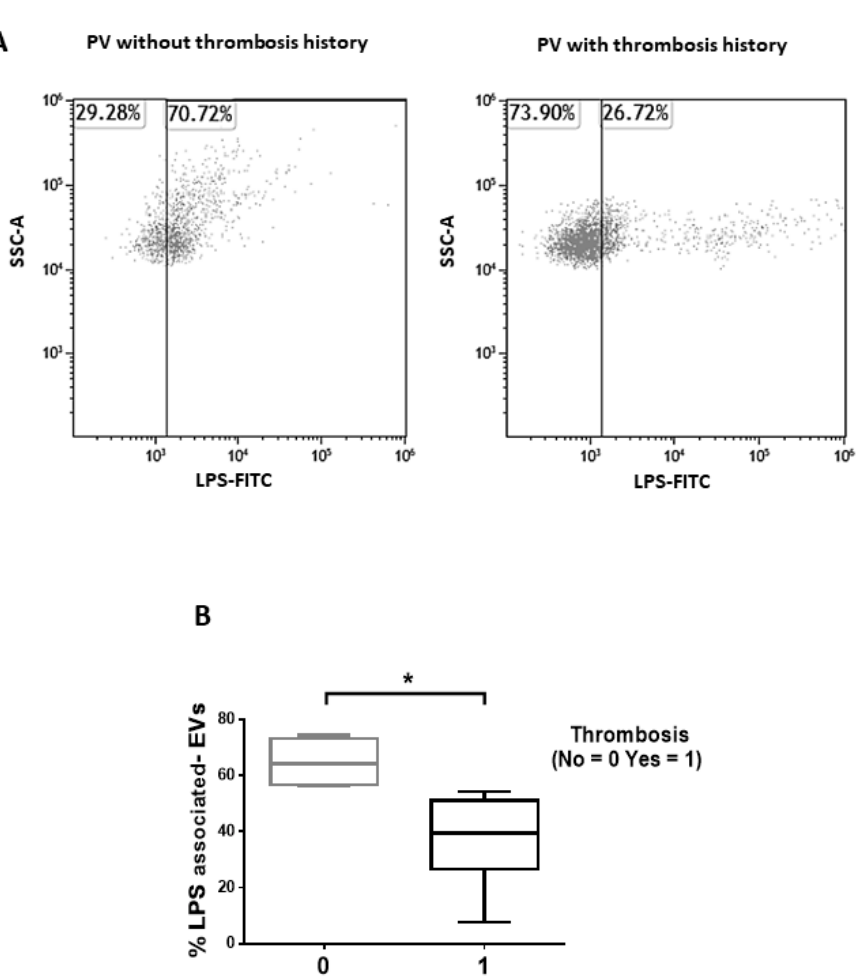
Figure 3. Proportion of LPS-associated EVs after isolation from the plasma of PV patients. ( A ) Representative dot-plots of LPS-associated EVs after isolation from the platelet-poor plasma of 1 PV patients with thrombosis history and 1 PV patient without thrombosis history. ( B ) Proportion of isolated LPS-associated EVs of PV patients with ( n = 14) or without thrombosis ( n = 24). Data are expressed as percentages and presented as min to max with median (Mann–Whitney test; * p < 0.05).